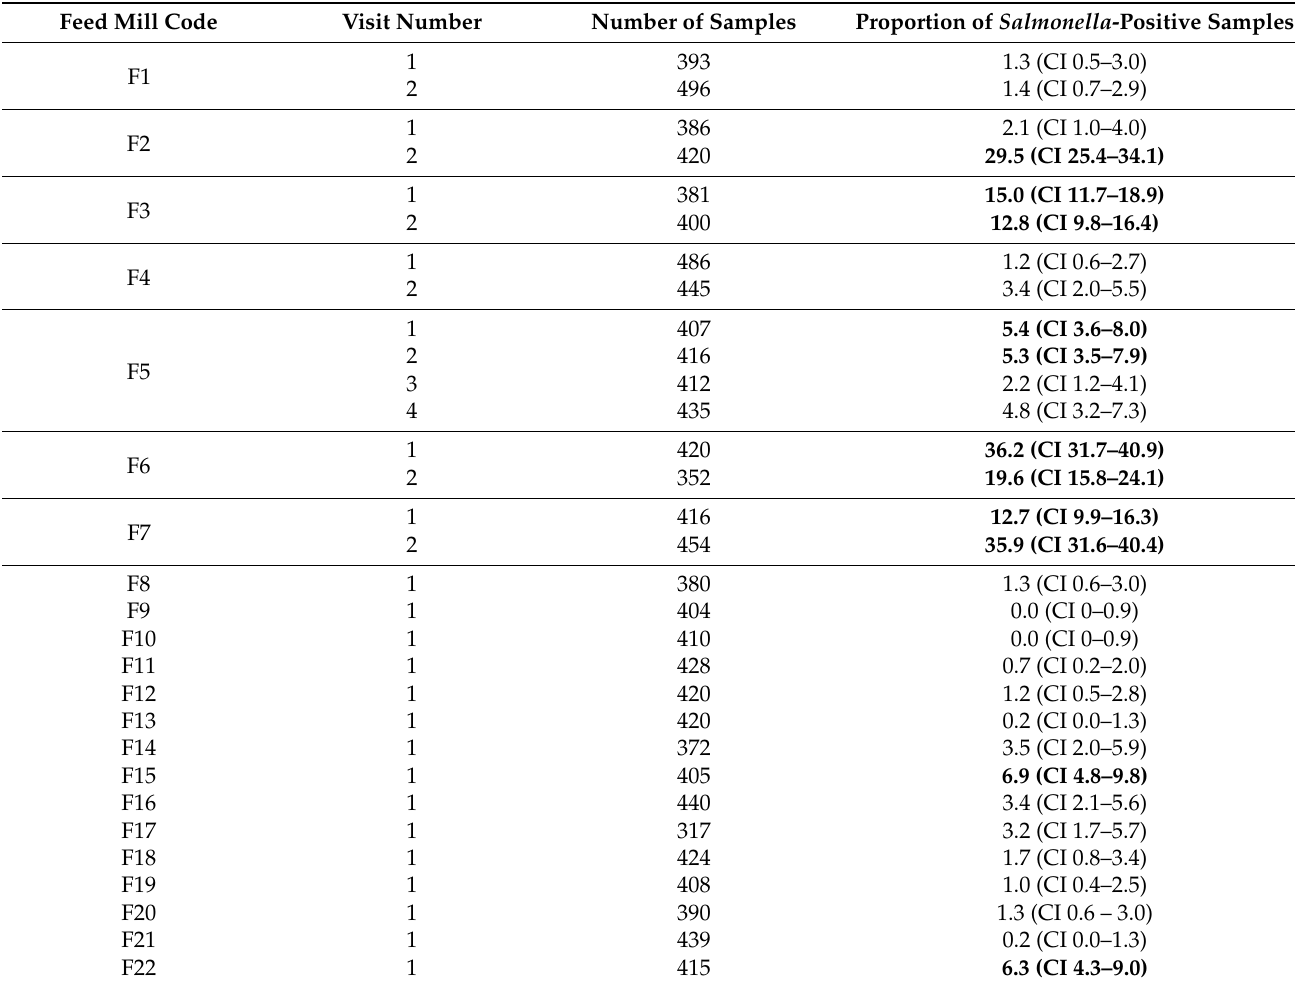
Table 1. Proportion of Salmonella -positive samples from each visit to 22 mills producing broiler feed. Feed Mill